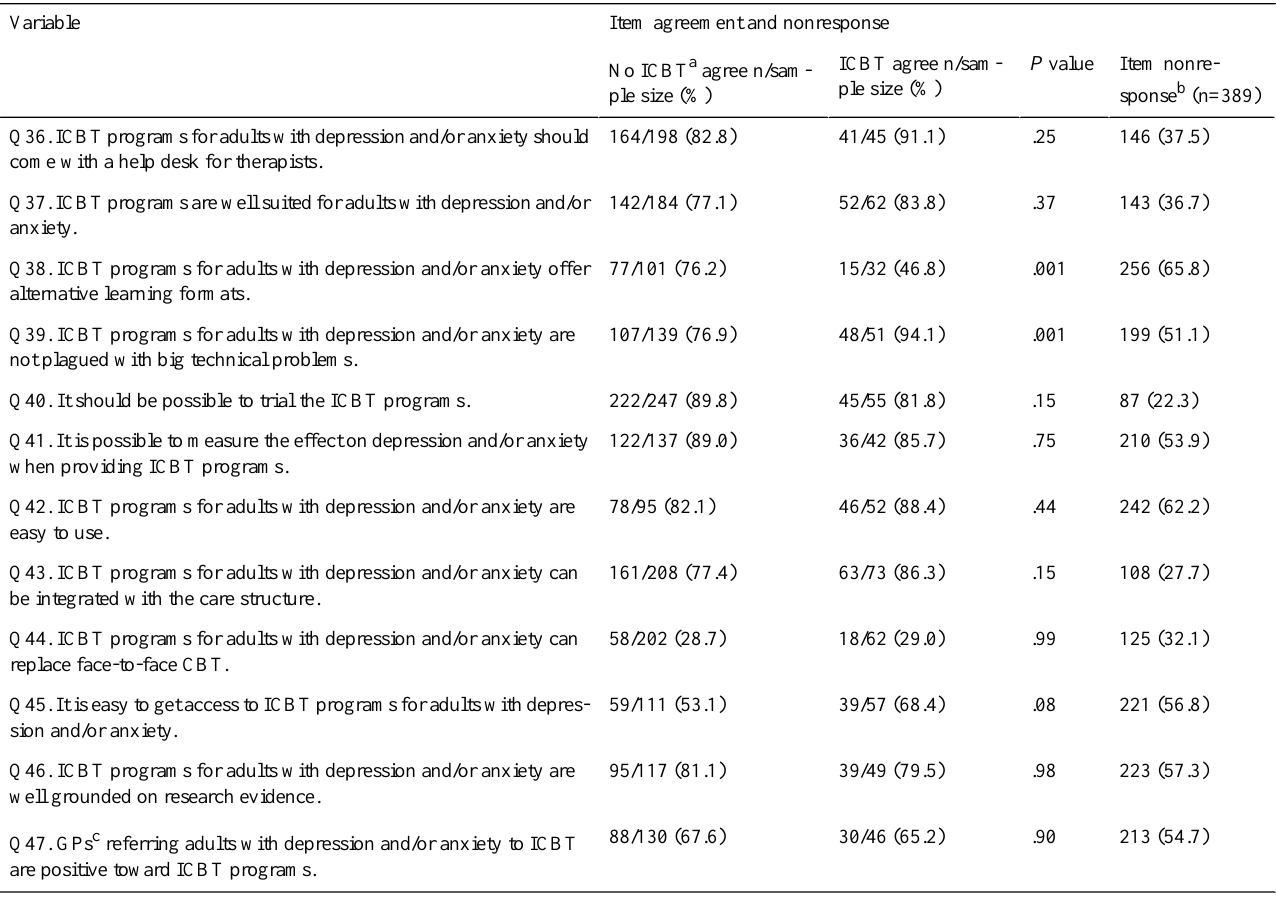
Table 4. Implementers and nonimplementers agreeing to program-related